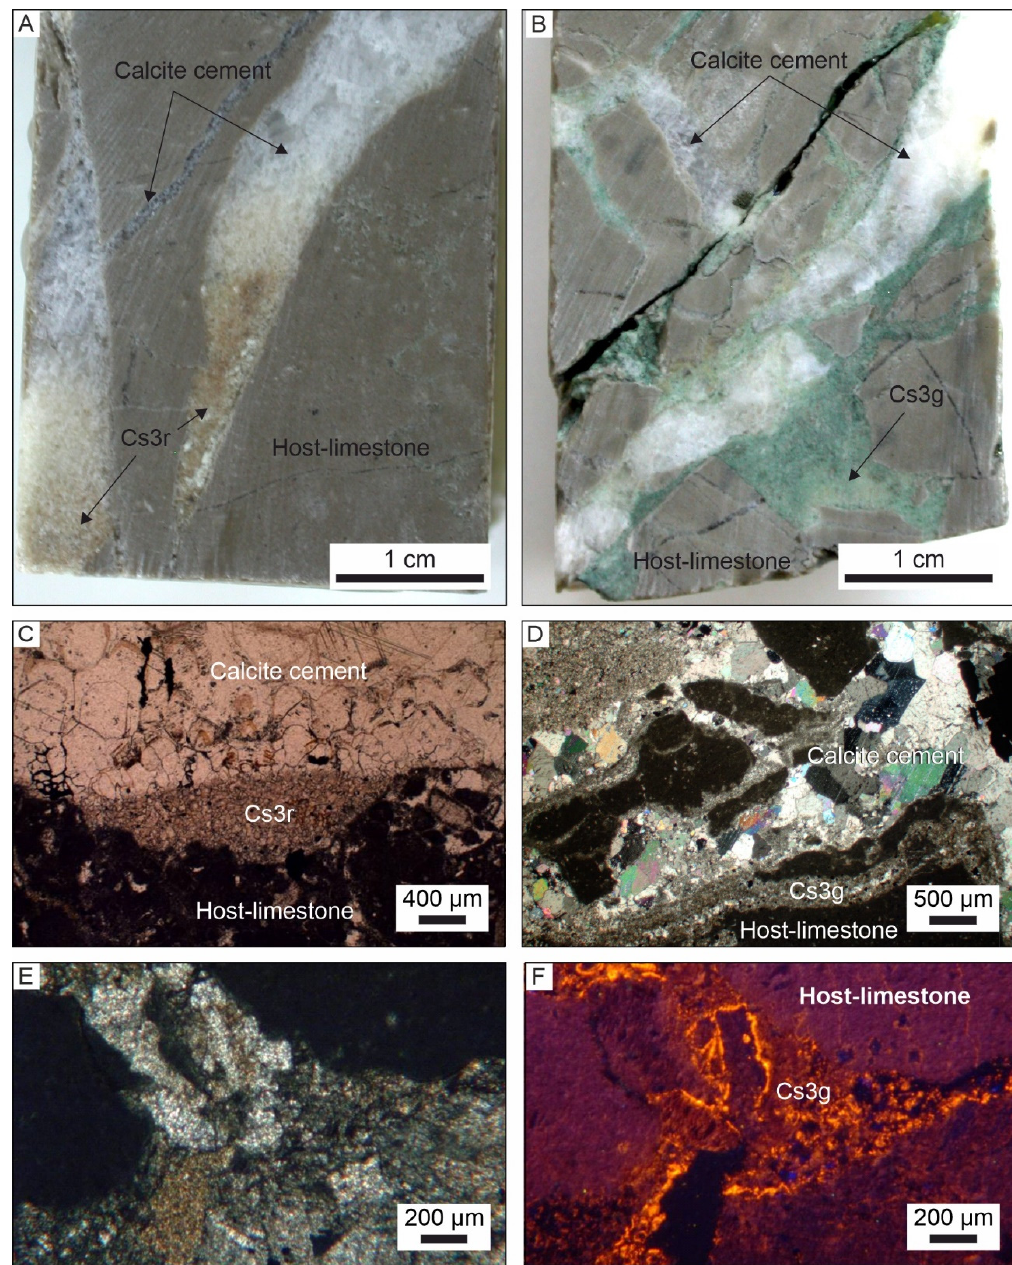
Figure 6. The main features of host limestones and reddish CS3r and greenish CS3g karst fills in the Amposta Marino C2 well (A to D photographs are from [16]). ( A ) Hand sample of CS3r filling fracture porosity within Lower Cretaceous limestones. ( B ) Hand sample with CS3g filling fracture porosity. ( C ) Photomicrograph of geopetal structure filled with CS3r and younger calcite cement (plane polarised light). ( D ) Photomicrograph of a brecciated host-limestone partially cemented by CS3g and calcite cement (cross polarised light). ( E , F ) Plane polarised light and cathodoluminescence (CL) images with CS3g filling fracture porosity in Lower Cretaceous limestones.